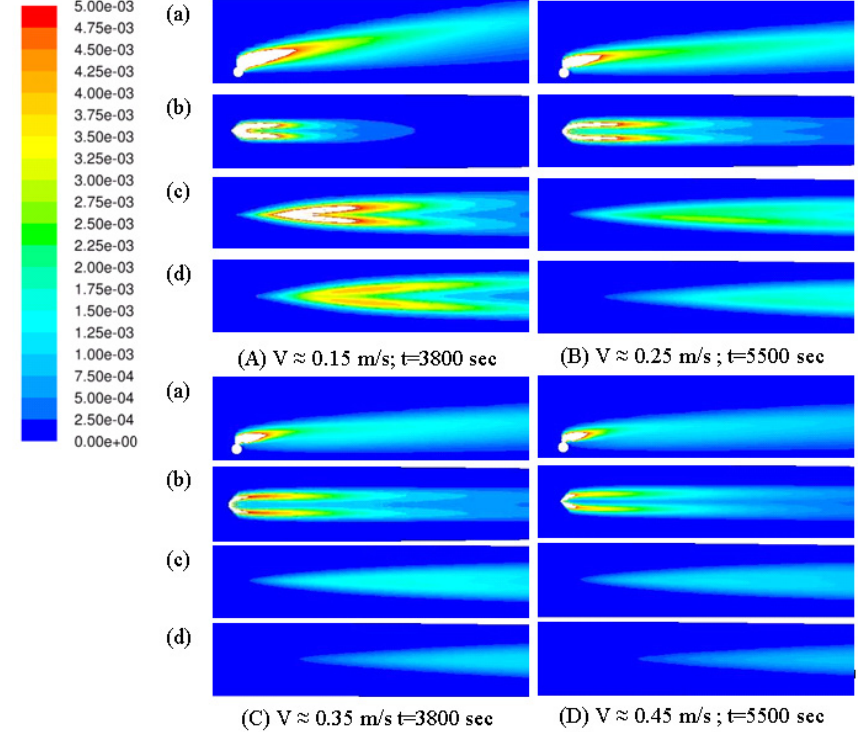
Fig. 10. Longitudinal views of pollutant concentration at four instants, for a periodic ambient current, BBL formulation without blockage; (a) vertical cross section passing through the port center, (b–d) top view at different distances above the seabed: (b) 1.2m; (c) 2.5m; and (d)